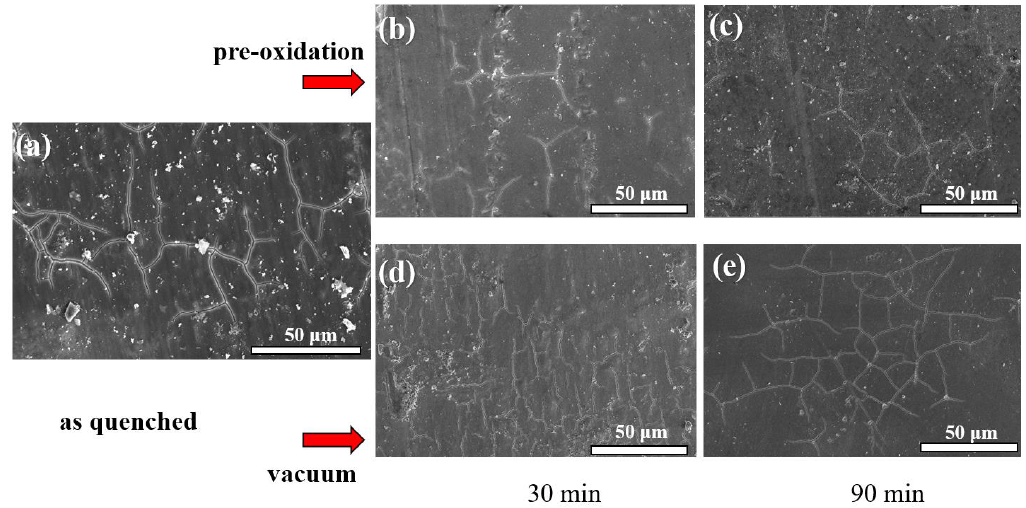
Figure 8. SEM image of the surface after corrosion. ( a ) as-quenched, ( b ) pre-oxidated for 30 min, ( c ) pre-oxidated for 60 min, ( d ) vacuum heat-treated for 30 min, ( e ) vacuum heat-treated for 60 min.